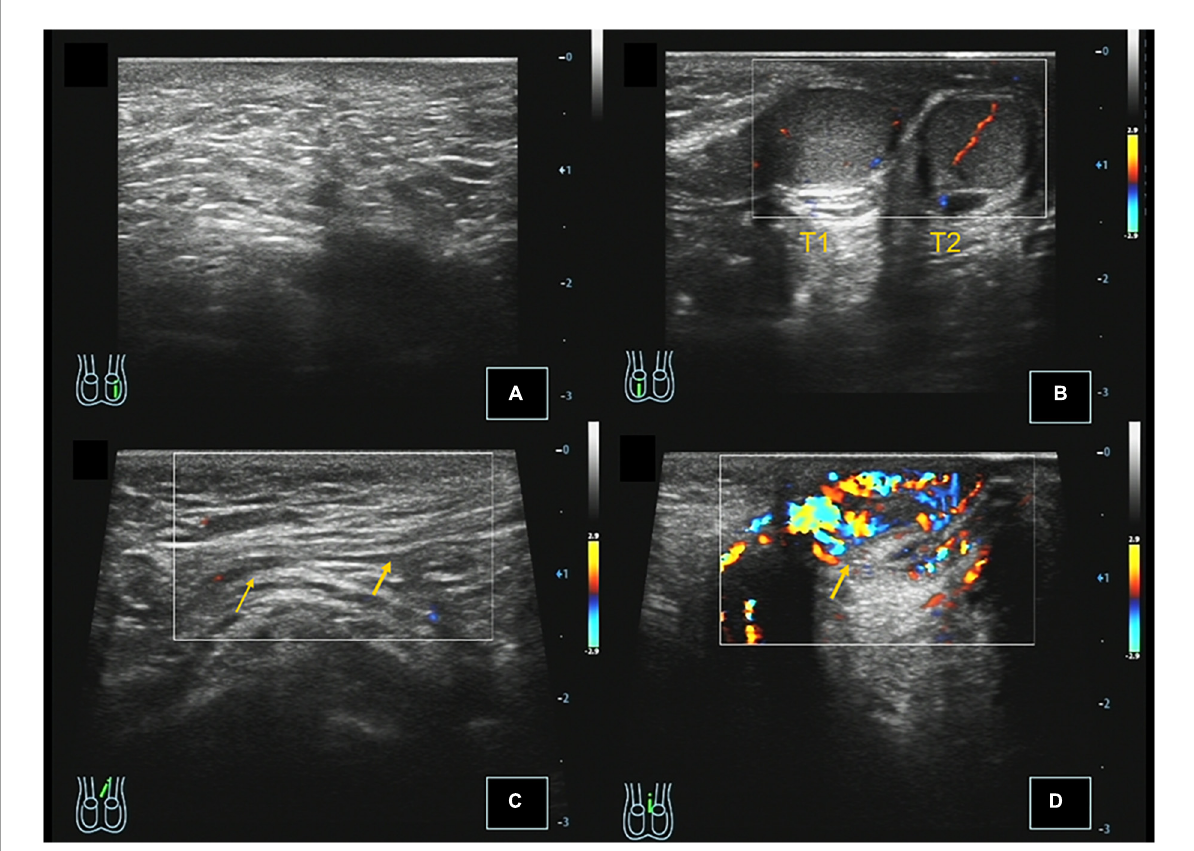
FIGURE1 Case 3, 0.67 years, chief complaint: left scrotal emptiness. Preoperative ultrasound: (A) Longitudinal section of the left scrotum showing no testicular echo in the left scrotum. (B) Longitudinal section of the right scrotum showing that there were two testes echoes in the right scrotum, and CDFI showed that there were punctate blood flow signals in the testis parenchyma. (C) Longitudinal section of the left inguinal region showing that the left spermatic cord extends through the perineum to the right scrotum, and CDFI showed the punctate blood flow signal in the left spermatic cord. (D) Left scrotal longitudinal section showing hemiscrotal hemangioma, and CDFI showed that the blood flow signal is abundant in the